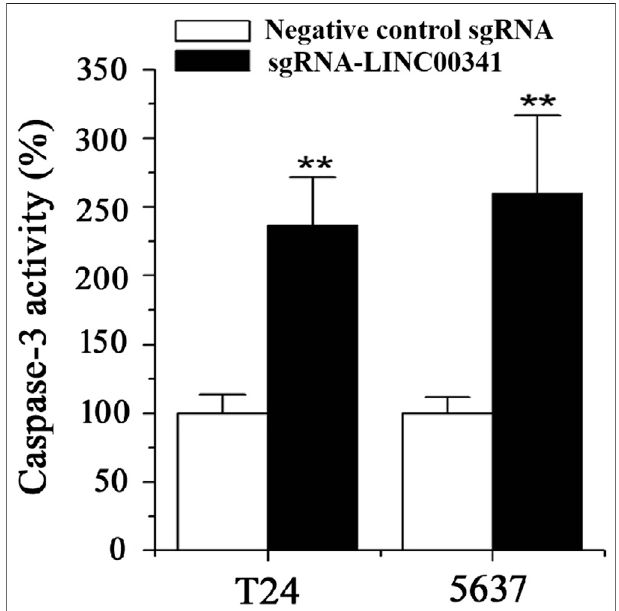
FIGURE 3 | Knockdown of LINC00341 by CRISPR-CasRx triggered apoptosis. 48 h post transfection with LINC00341 sgRNA or the negative control sgRNA, the changes of apoptosis were measured by ELISA. Apoptosis induction was observed in T24 cells (** p < 0.01) and 5,637 cells (** p < 0.01) transfected with LINC00341 sgRNA via ELISA. The data is indicated as the average ± SD. The experiments were conducted in triplicates for three independent times for both cell